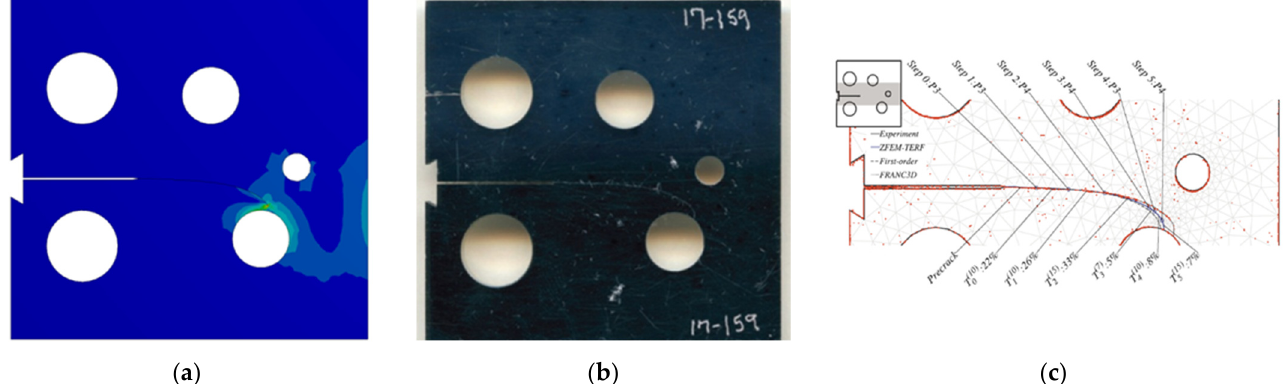
Figure 10. Case 2, predicted crack growth trajectory by ( a ) present study, ( b ) experimental, and ( c ) numerical crack paths obtained by [51].